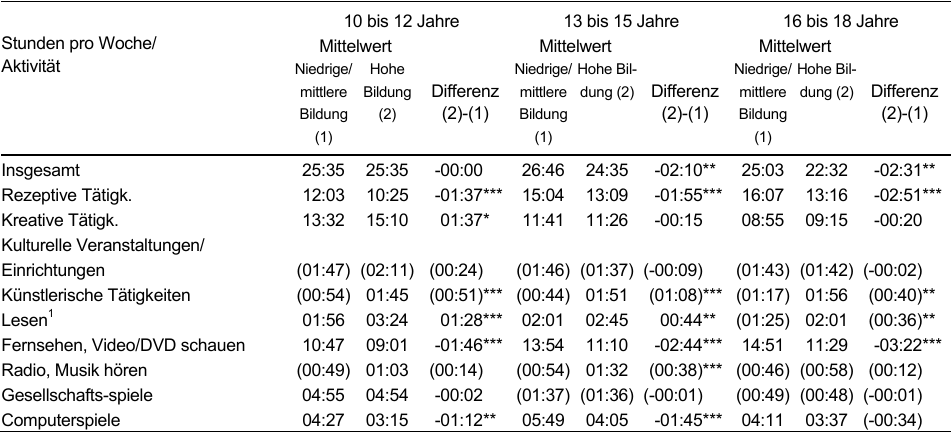
Tabelle 8 : Zeitverwendung für kulturelle und musisch-ästhetische Aktivitäten von Kindern unterschiedlicher Altersgruppen nach höchstem Bildungsstand